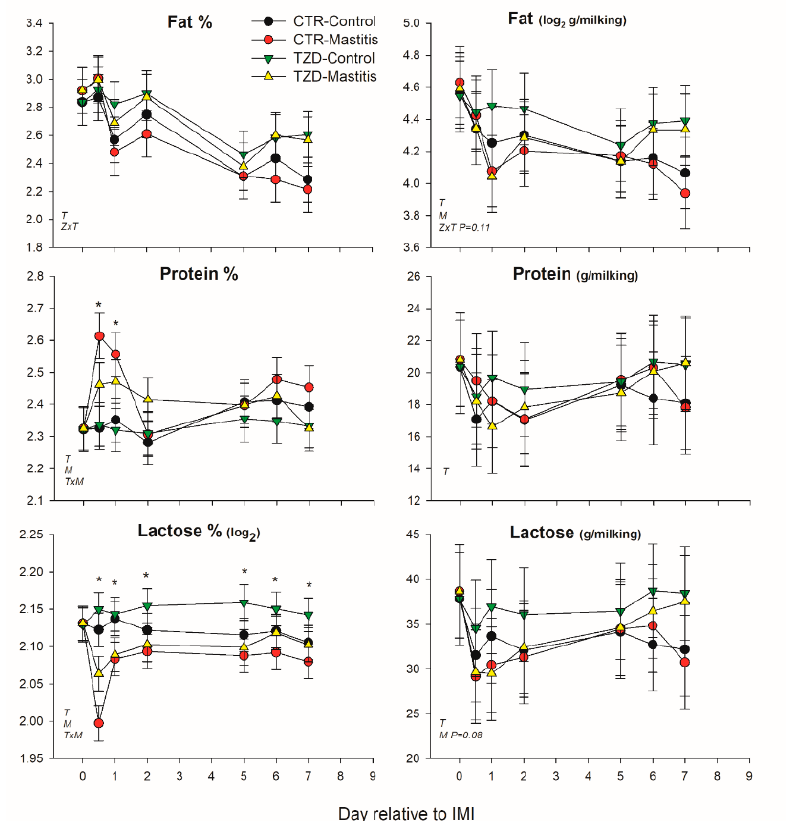
Figure 3. Effect on milk components of a daily injection of 2,4-thiazolidinedione (TZD) and saline (CTR) in Saanen dairy goats plus intramammary infusion in the right half of the mammary gland with Strep. uberis (Mastitis) while the left half of the mammary was left untouched (Control). Overall statistical significance ( p ≤ 0.05) is indicated in the plot as follows: T = time effect; M = IMI effect; Z = effect of 2,4-thiazolidinedione injection. When a significant ( p ≤ 0.05) interaction was present for T × M, * denotes the difference between groups at each time point. Table 1. Blood metabolic parameters in goats treated with 2,4-thiazolidinedione (TZD) or saline (CTR) after infusion in the right gland of 7 × 10 8 colonies of Streptococcus uberis (i.e., IMI). Day from IMI Parameter Group Glucose (mM)